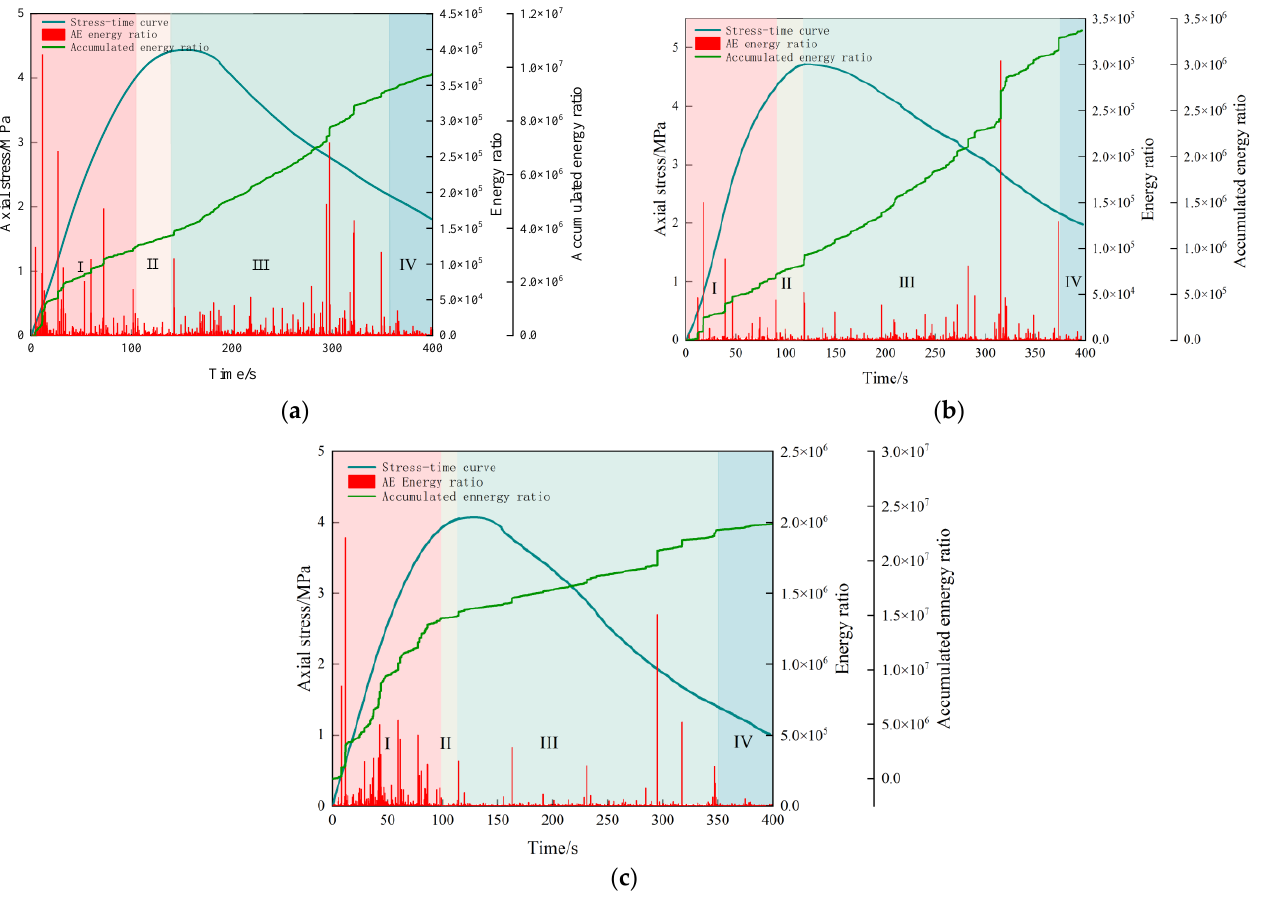
Figure 22. Uniaxial compressive stress and AE energy diagrams of sandstone – CGFB composite samples. ( a ) C1; ( b ) C2; ( c ) C3.